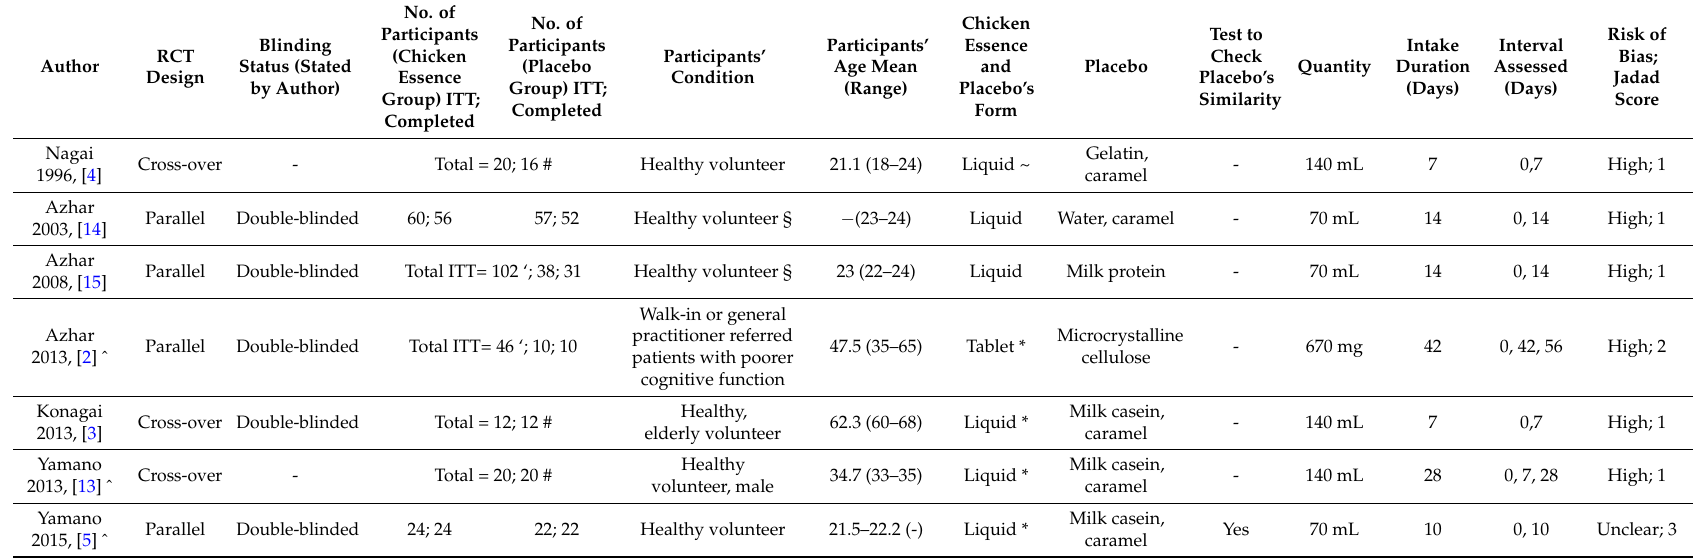
Table 1. Study characteristics of included